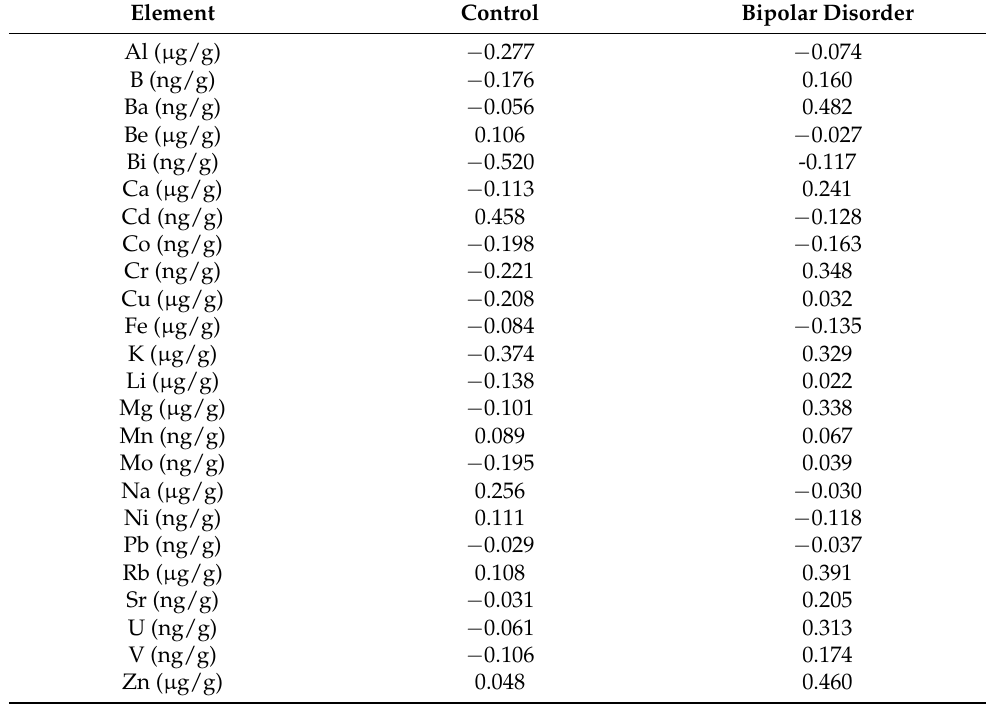
Table 5. Spearman’s rank correlations coefficient between elemental concentrations in PFC of BD patients and control subjects with age. Element